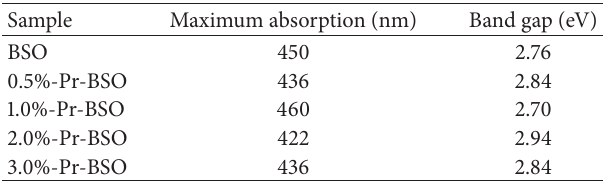
Table 2: Maximum absorption and band gap of as-prepared